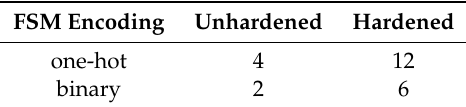
Table 4. Simple_fsm state